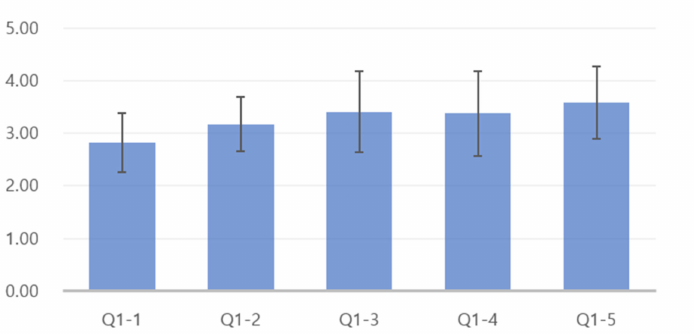
Figure 11. Results showing service satisfaction with tourist attraction